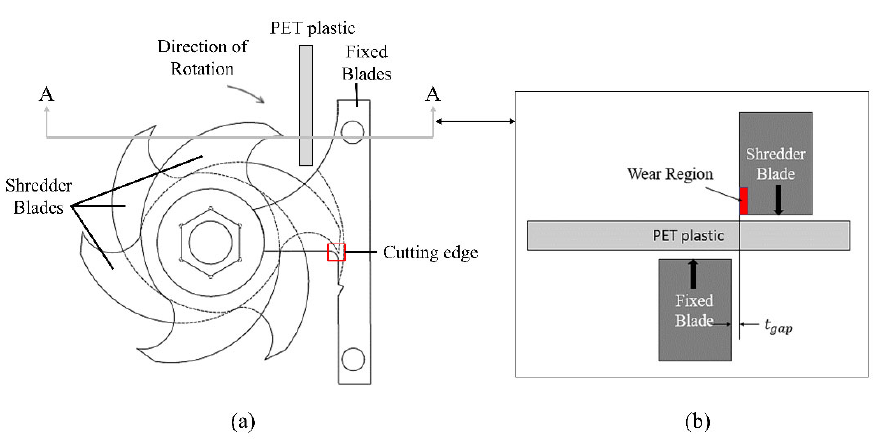
Figure 5. ( a ) Shredding action on the PET plastic by the shredder blades from side view, and ( b ) the cross section of the two blades and the gap, t gap .